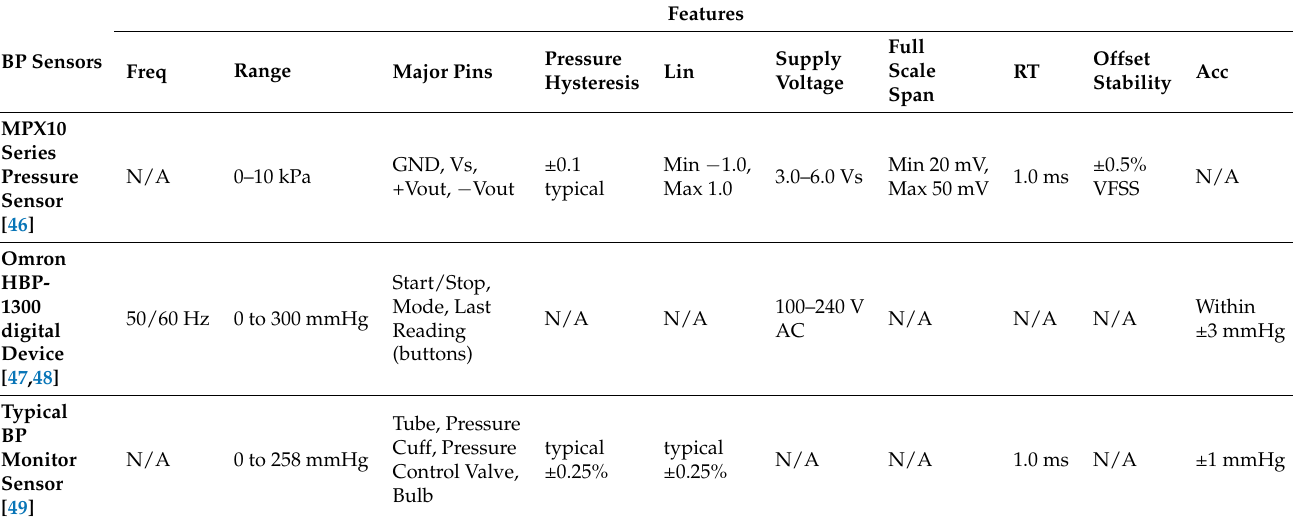
Table 7. Features of blood pressure